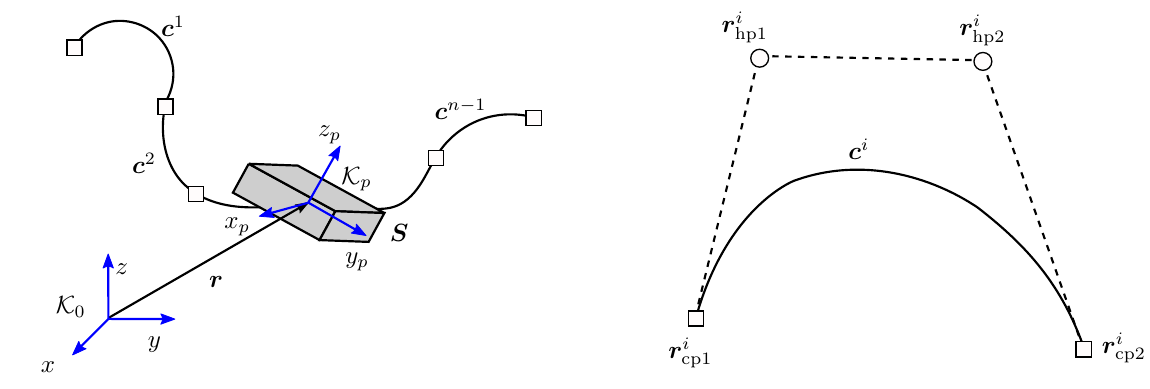
Figure 2. Main concept of path planning ( left ) and cubic Bézier curves ( right